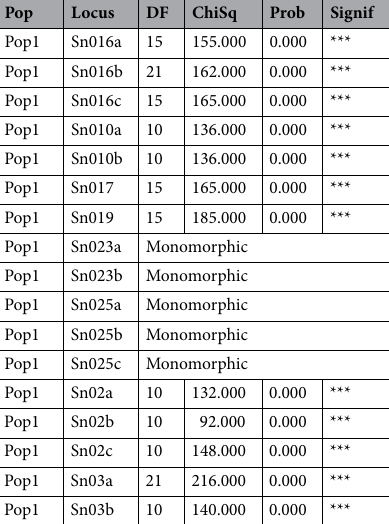
Table 6. Summary of chi-square tests for Hardy–Weinberg equilibrium. Key: ns = not significant, * P < 0.05, ** P < 0.01, *** P < 0.001.